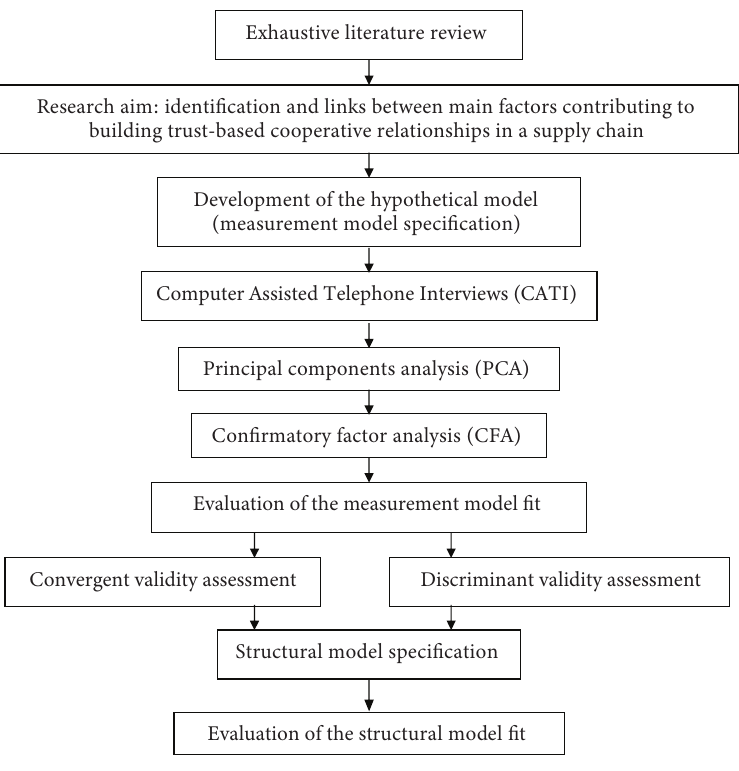
Figure 3. Methodology adopted for the